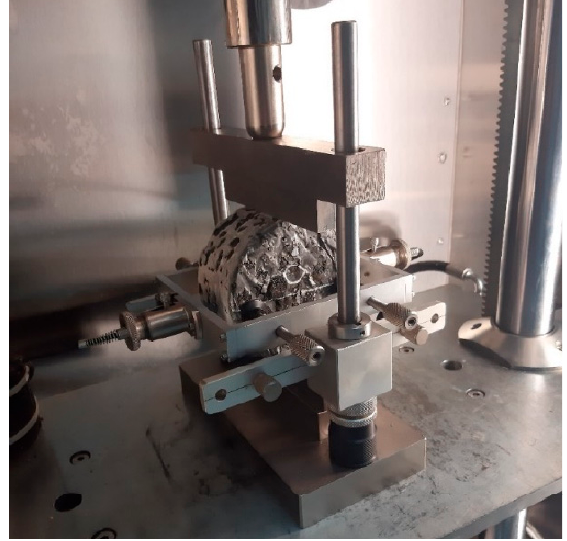
Figure 2. The sample position in the UTM for ITSM testing.